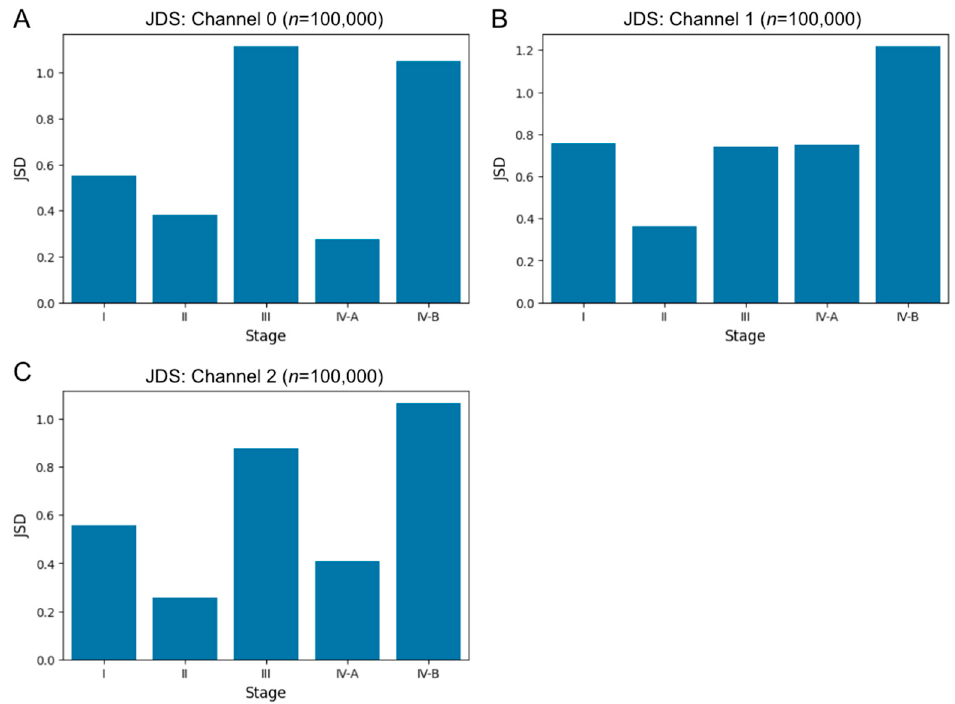
Figure 7. Jensen–Shannon divergence (JSD) of pixel-wise entropy in red ( A ), green ( B ), and blue ( C ) channels between cancerous and noncancerous regions at each cancer stage for human specimens.